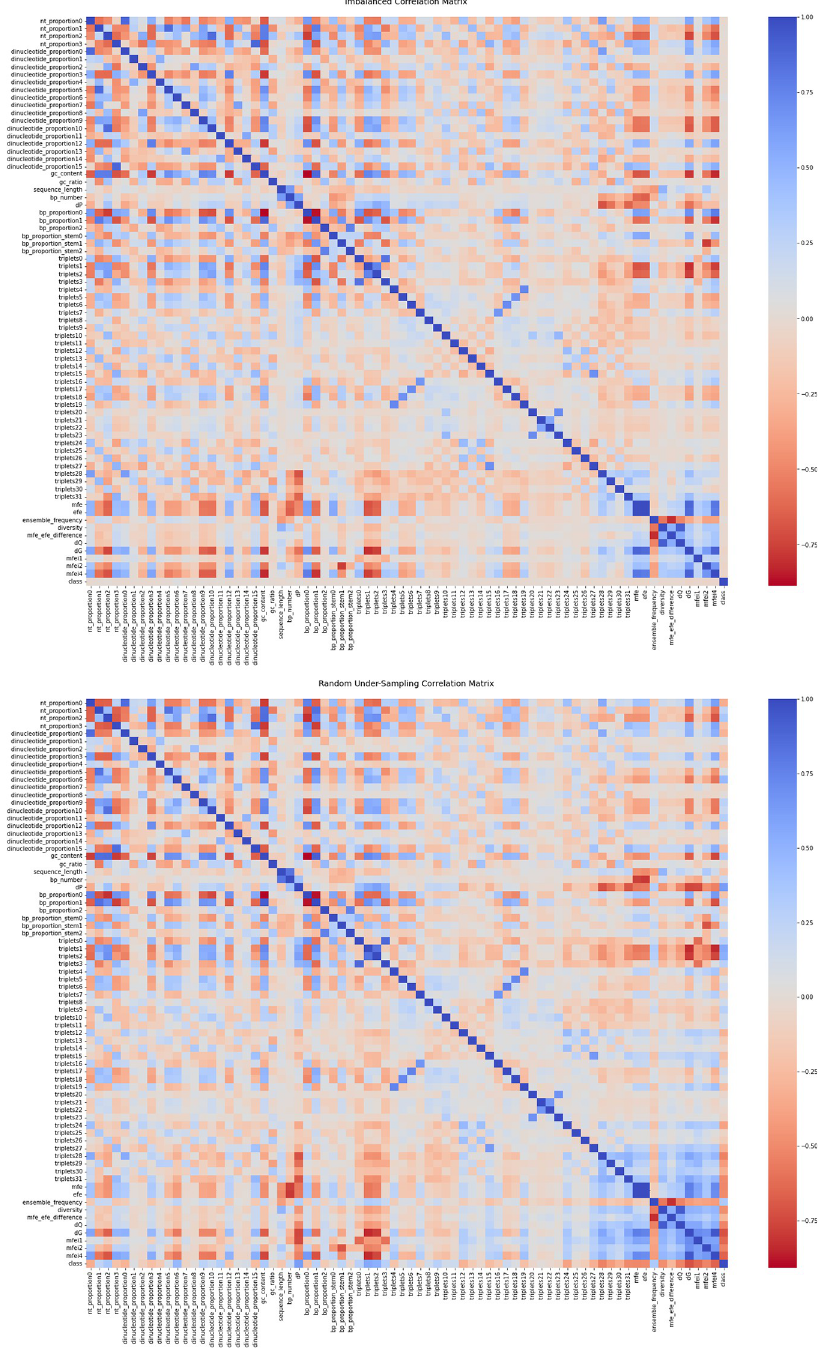
Fig 2. The heat map shows the patterns, similarities, associations, correlations and expression of